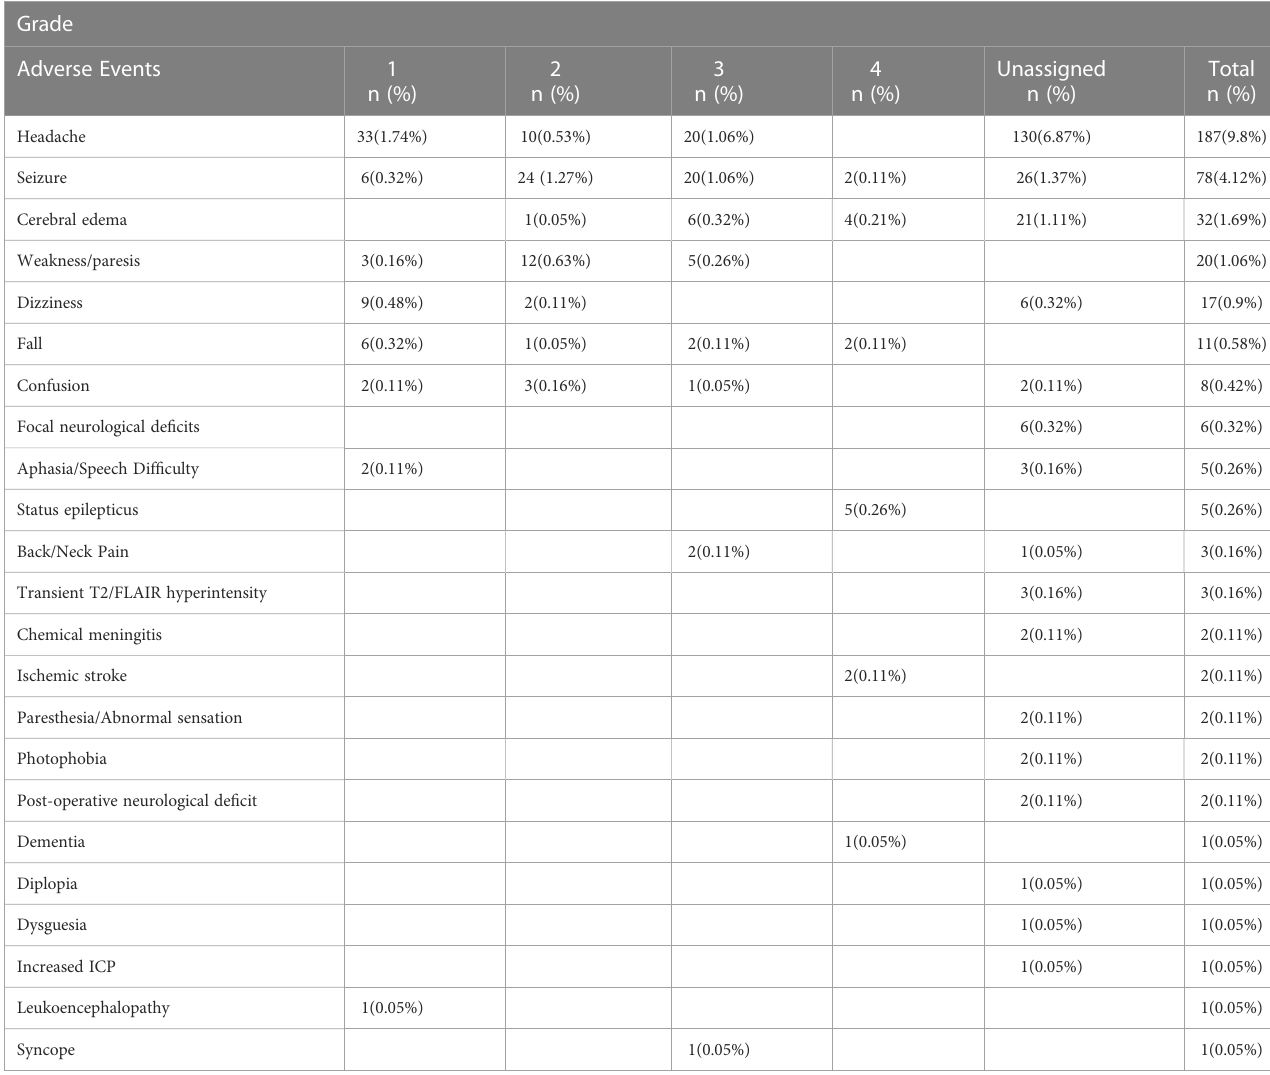
TABLE 6 Summary of All CNS Adverse Events across 56 Vaccine Clinical